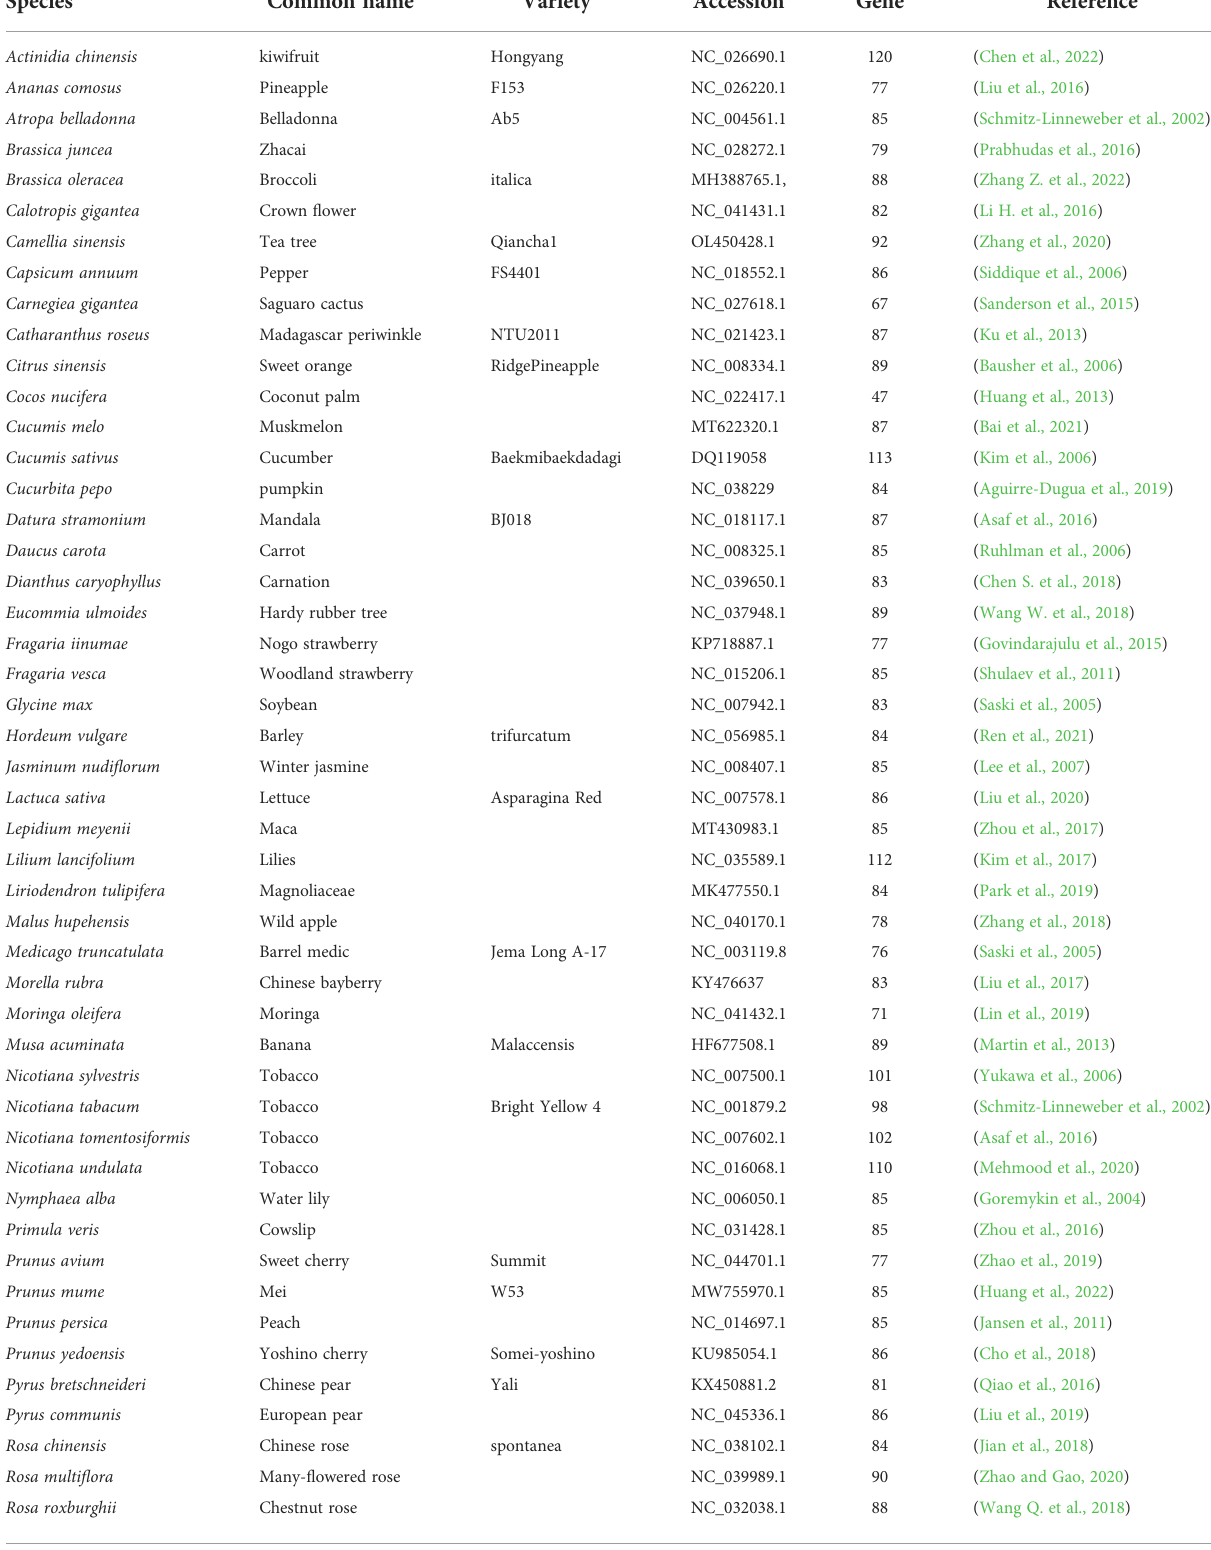
TABLE 1 Complete sequence of chloroplast genome from horticultural